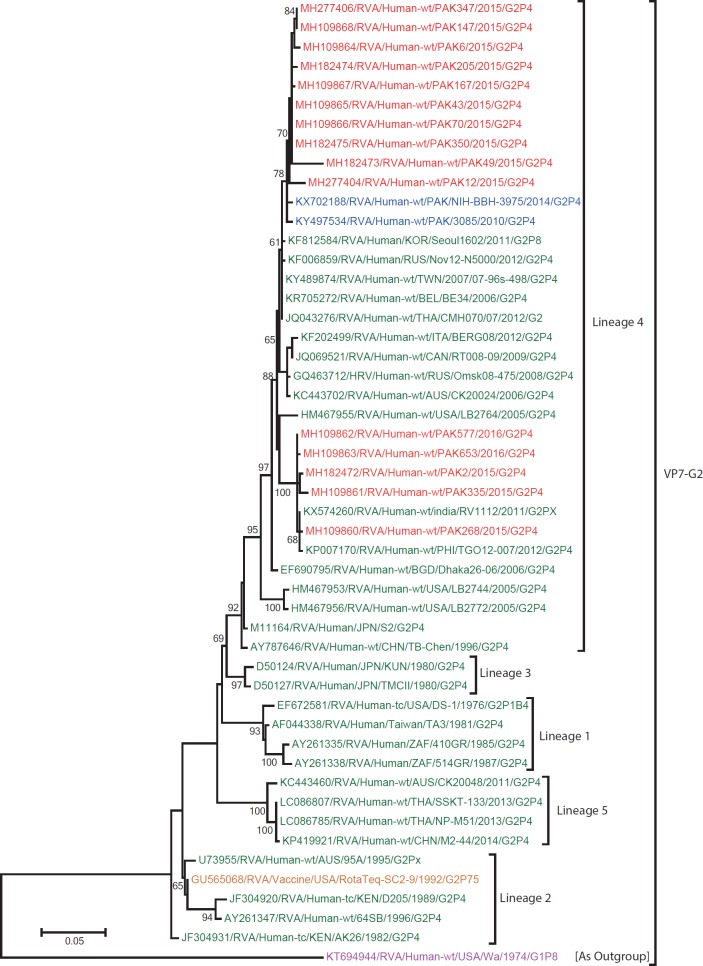
Maximum likelihood phylogenetic tree constructed from the nucleotide sequences of G2-VP7 strains and representative RVA strains with kimura-2-parameter model in MEGA program 6.0.Bootstrap values <60 are not shown. RVA strains sequenced in this study are represented by the red colour. Pakistani Strains reported in the previous studies are shown in blue. The vaccine strains and an out group strain are represented by purple and orange colour respectively while green shading represent strains isolated in all over the world. The RVA strains sequenced in this study and reference strains obtained from GenBank database are represented by Accession number, Strain Name, Country and year of Isolation. Scale bar: 0.05 substitutions per nucleotide.